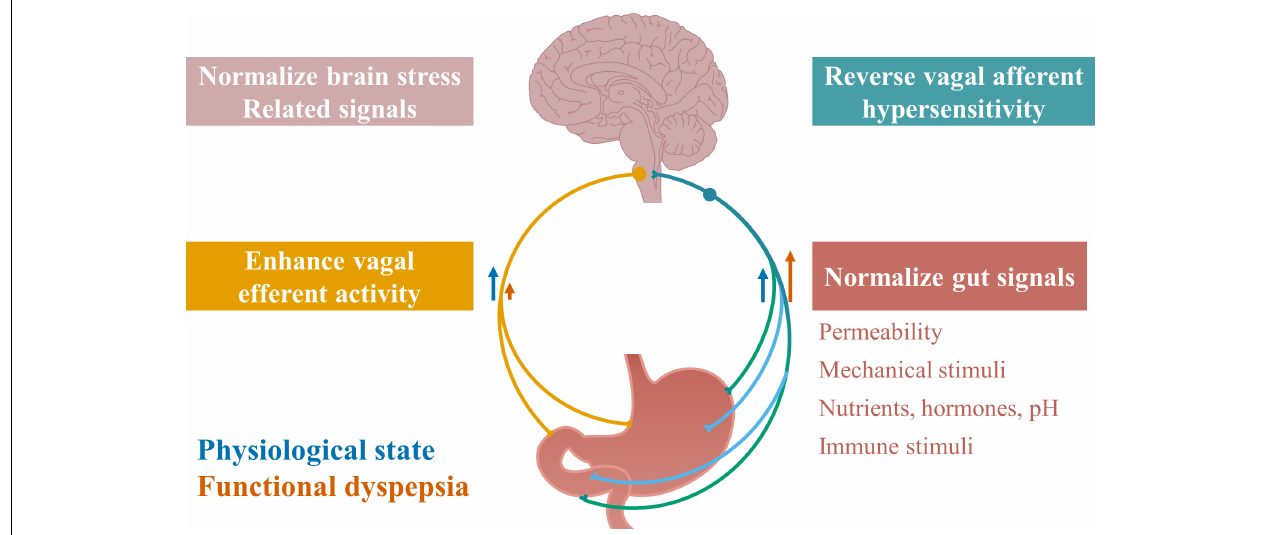
FIGURE 3 | Therapeutic targets along vagal signaling pathways in functional dyspepsia. Restoring normal vagal signaling could be an important therapeutic target for functional dyspepsia, by normalizing any component in the vagal signaling loop, including normalizing gut signals, reversing vagal afferent hypersensitivity, normalizing brain stress related signals, and enhancing vagal efferent activity. Normalizing gut signals may target gastroduodenal permeability, mechanical stimuli, and chemical stimuli including nutrients, hormones, pH levels, and immune stimuli including